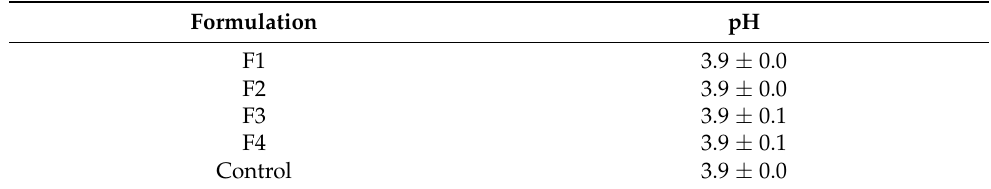
Table 2. The pH values of hand sanitizer gel formulations. The result represents the mean ± SD of three replicates ( n =